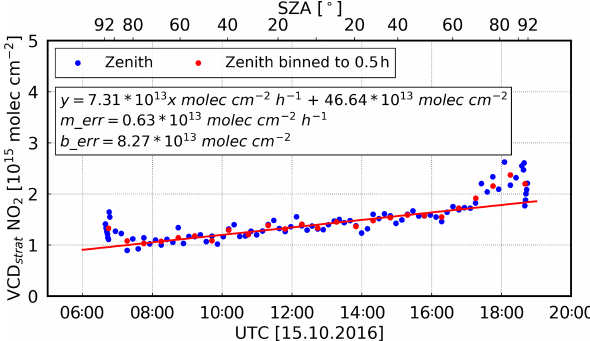
Figure 7. The diurnal cycle of stratospheric NO 2 (15 October 2016; latitude: ∼ 2.5 ◦ N; longitude: ∼ 13.9 ◦ W). In red, the data are binned to 0.5h values to improve the signal-to-noise ratio. Also shown is the regression line which represents a linear increase dur- ing the day. The data are shown for SZAs smaller than 92 ◦ . Fur- thermore, the errors of the slope ( m err ) and of the intercept ( b err ) are presented.